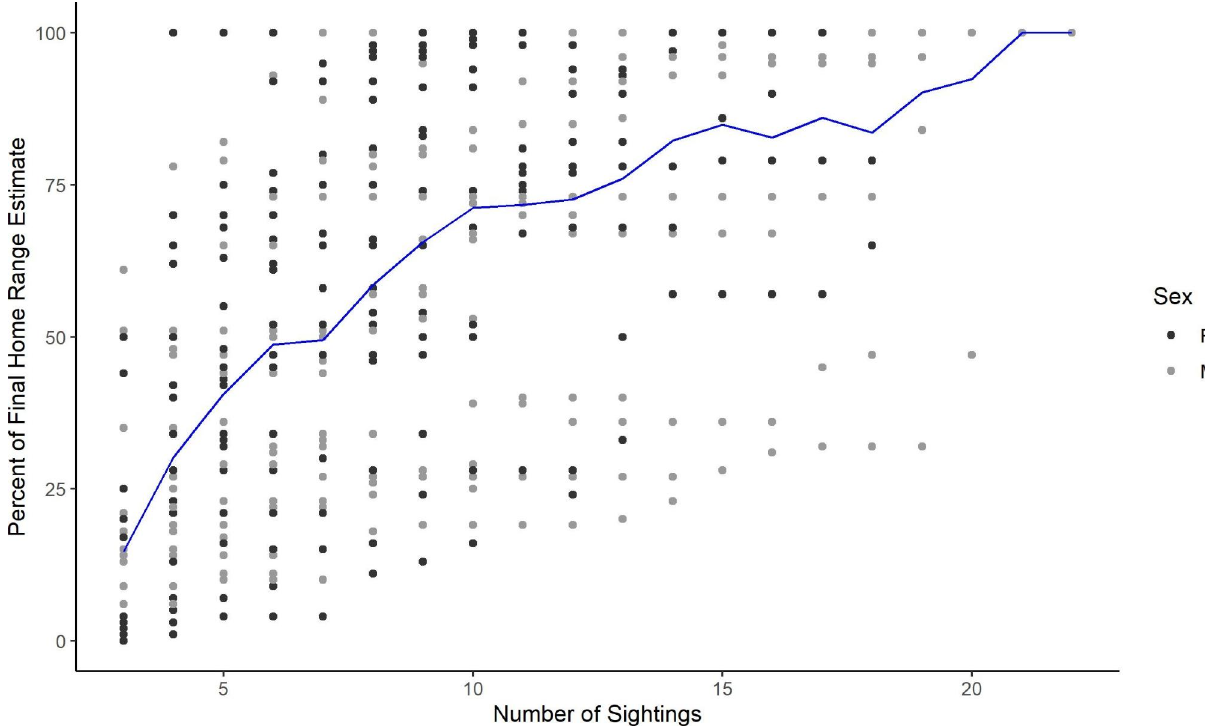
Fig. 4 Relationship between the number of sightings and the final home range estimation. The number of sightings used to calculate home range size versus percent of the final home range estimate. Black points represent female lizards, while gray points represent male lizards. The blue line is the average percent of the final home range estimate for animals with a given number of points used to assess home